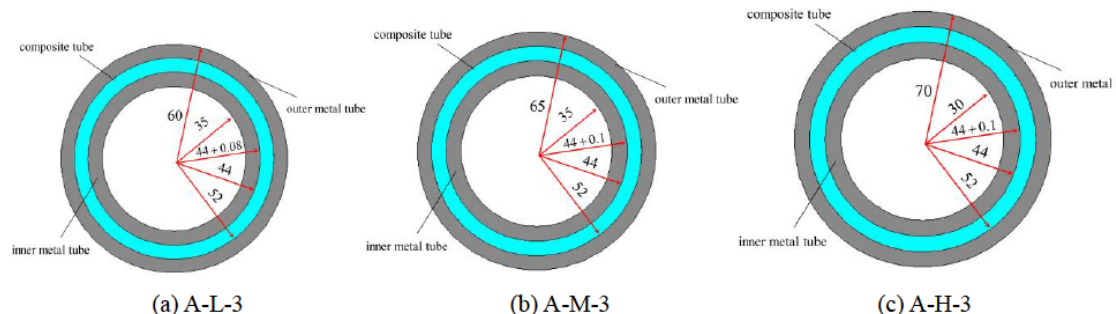
Figure 3: Diagram of three tubes under preload